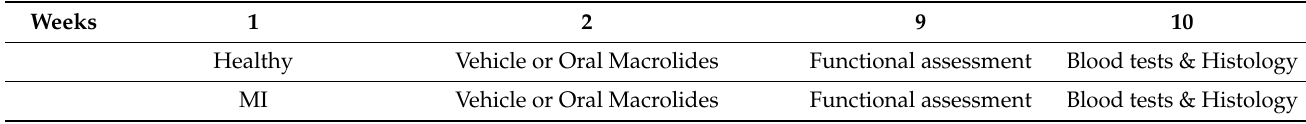
Table 2. A diagram demonstrating the course of the